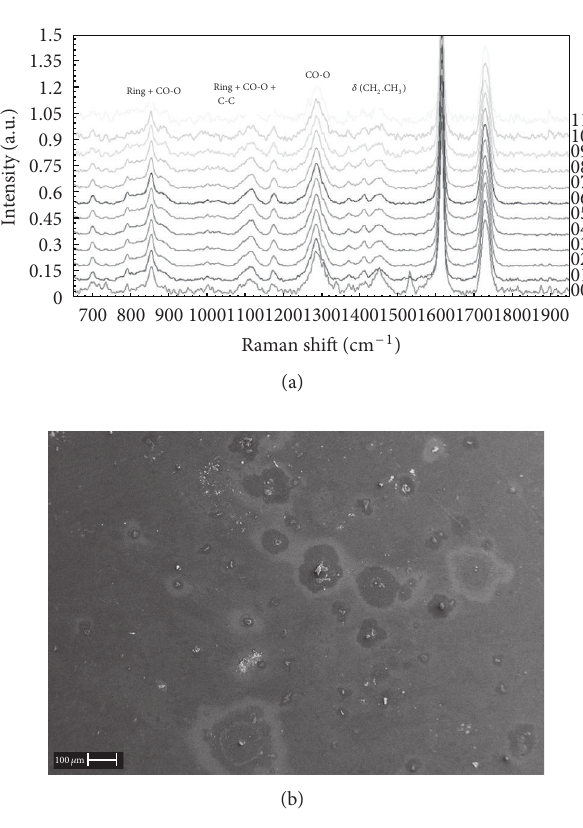
F 6: Spectra parallel to the PET with micro-Raman analyses of cross-sections every 5 m from the PET surface to the ECCS interface. 𝜇𝜇